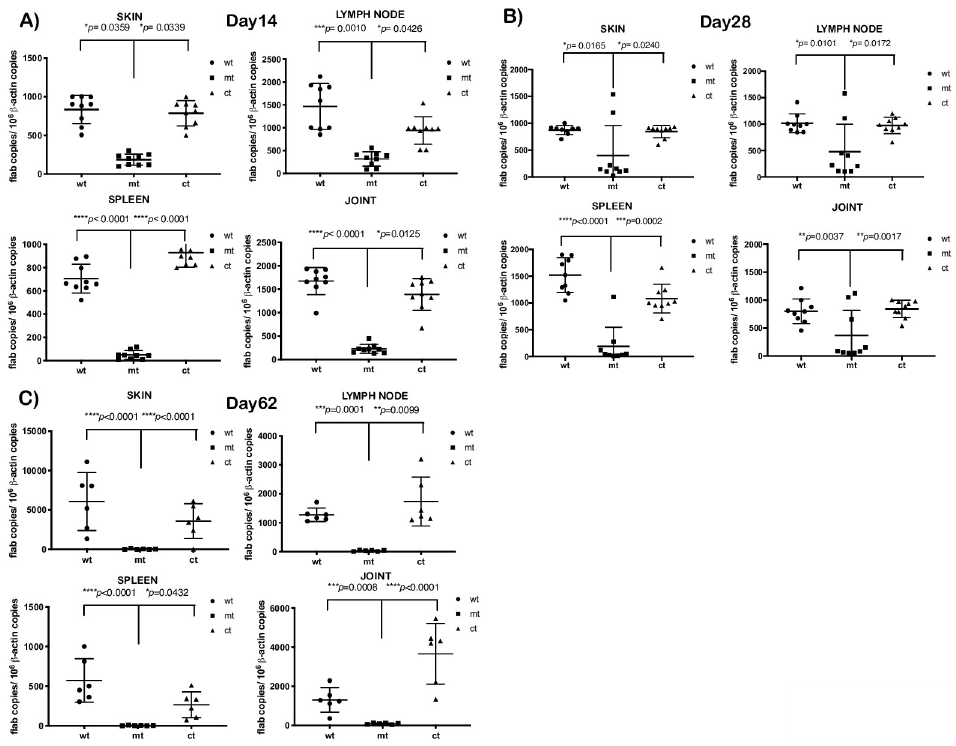
Fig 7. Quantitative real-time PCR analysis of spirochetal burden in C3H/HeN mice infected with bpiP mutant. Groups ( n = 3) of 4-week old C3H/HeN mice were intradermally infected via needle inoculation with wt, mt and ct strains with 10 5 spirochetes per mouse and data from 3 such independent experiments (total n = 9 mice) were analyzed. Total genomic DNA was isolated from tissue (skin, lymph node, spleen and one joint) using the High Pure PCR template preparation kit and was then subjected to quantitative real-time PCR. Numbers of borrelial flaB copies were normalized against total mouse β -actin. Data analyzed using a one-way analysis of variance test with Tukey’s multiple- comparison test. Statistical significance was accepted when p values were less than 0.05. Tissues samples analyzed were collected at day (A) 14, (B) 28 and (C) 62 post-infection.